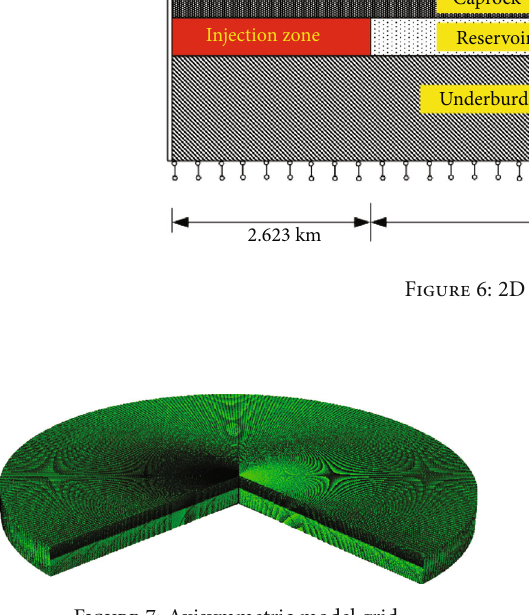
Figure 7: Axisymmetric model